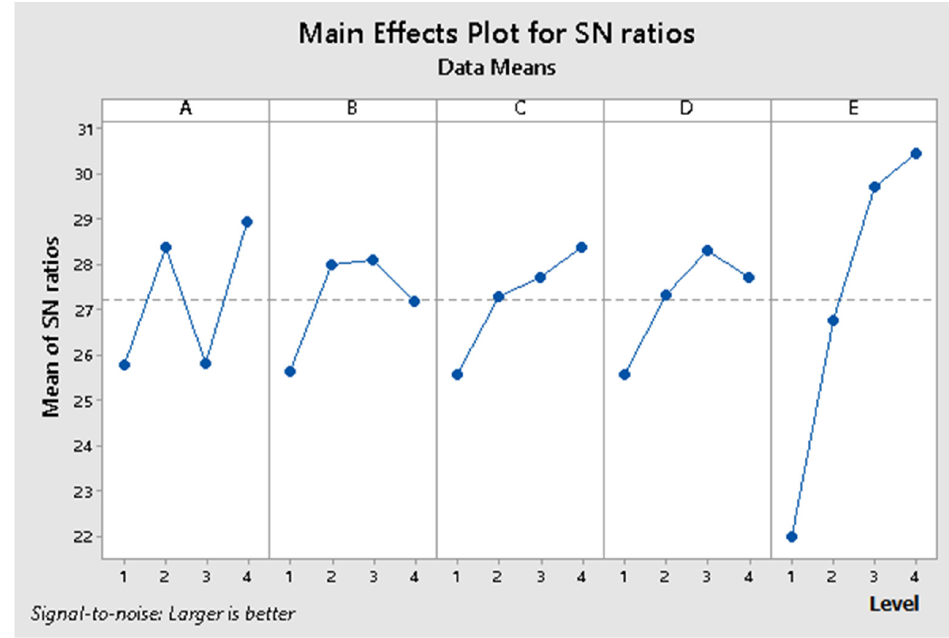
Figure 6. The values obtained for the main effects plot for S/N ratio.